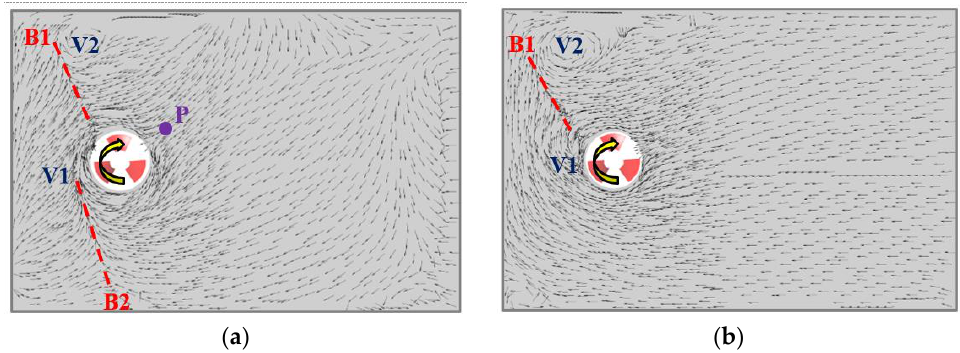
Figure 22. Velocity vector distribution of cross-section at different axial positions. ( a ) S1, ( b ) S3.